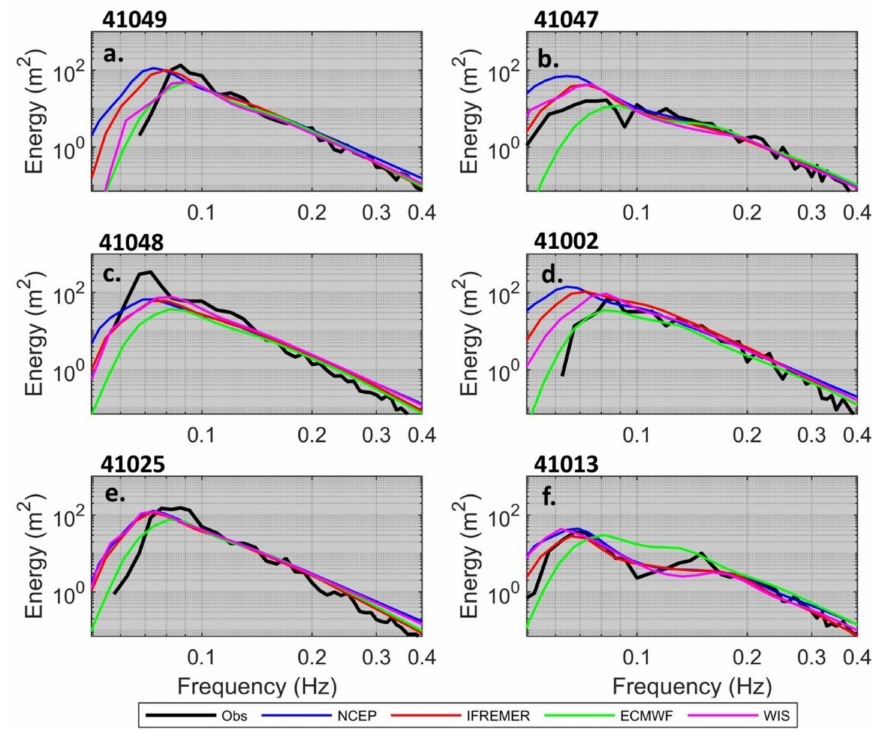
Figure 13. Buoy-model 1D wave spectra comparisons at red-dotted lines (see Figures 12 and 14) for buoys ( a ) 41049, ( b ) 41047, ( c ) 41048, ( d ) 41002, ( e ) 41025 and ( f ) 41013 during Hurricane